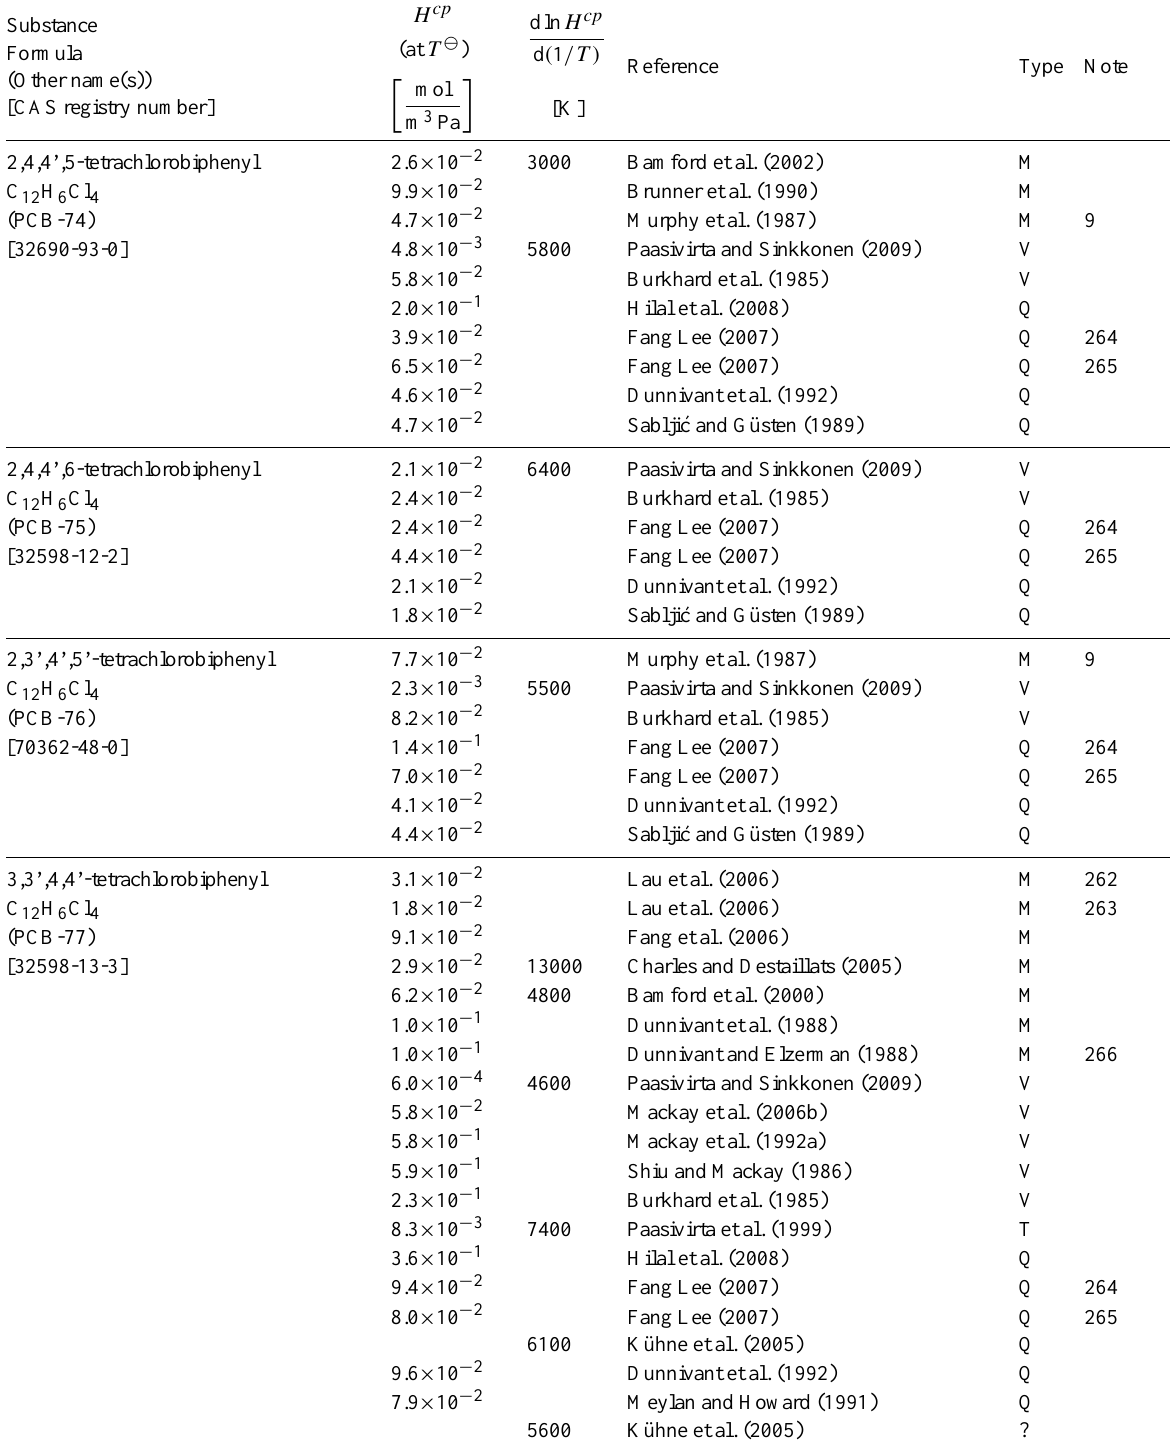
Table 6: Henry’s law constants for water as solvent